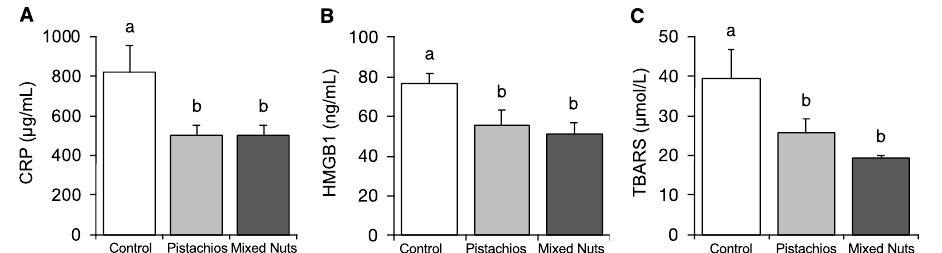
Figure 2. Effects of pistachios and mixed nuts on ( A ) CRP, ( B ) HMGB1, and ( C ) TBARS. Bars represent means ± SE (standard error). Bars with different superscripts differ significantly at p < 0.05. CRP, C-reactive protein; HMGB1, high mobility group box 1 protein; TBARS, thiobarbituric acid reactive substances.